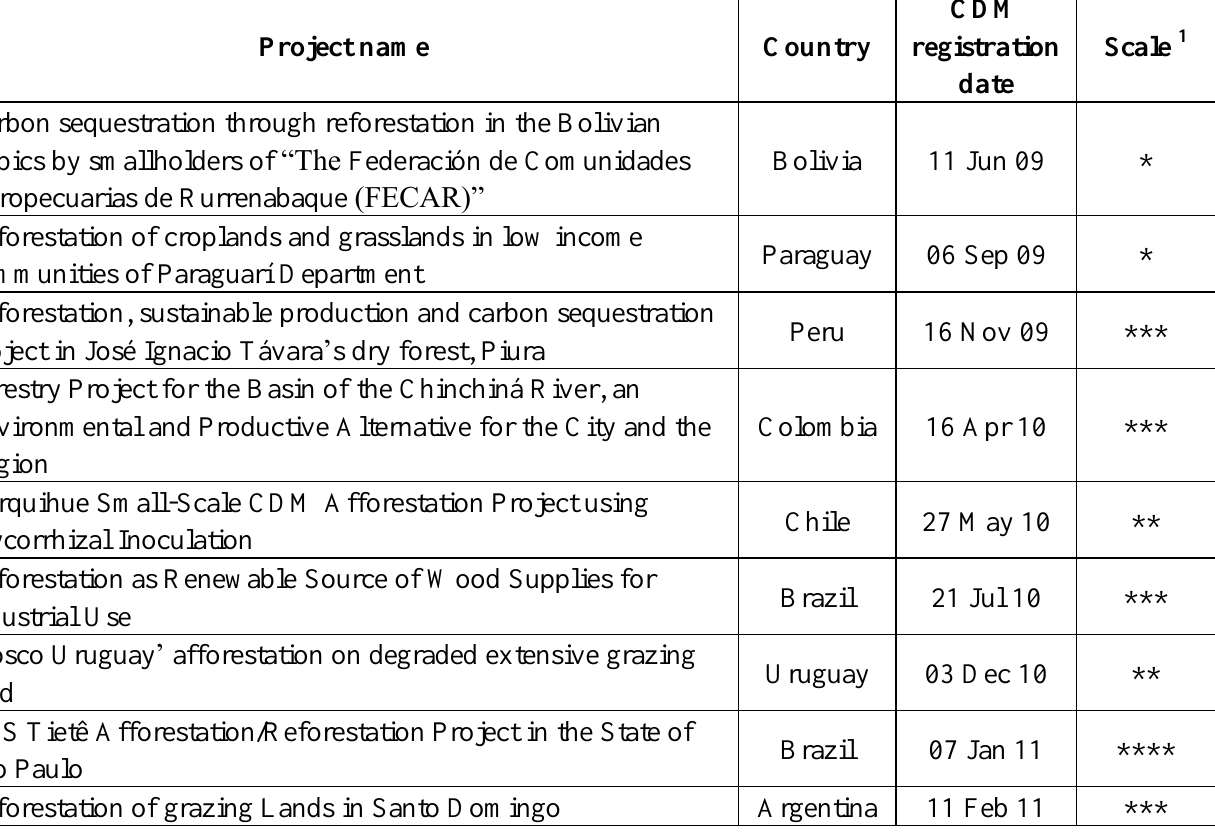
Table 2. Latin American forestry projects registered as Clean Development Mechanism (CDM) projects by the UNFCCC as of 28 February 2011